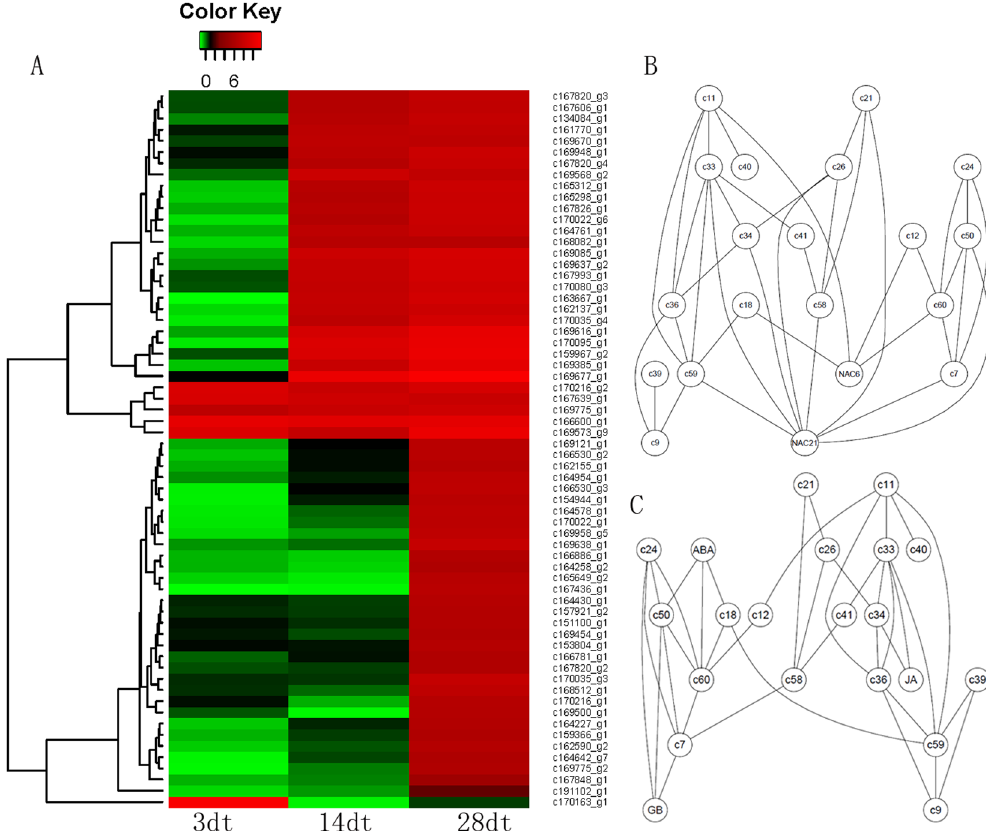
Figure 8. The expression pattern and co-expression network of cytoskeleton-related DEUs. ( A ) The log2 Ratio values of Cm cytoskeleton related DEUs were used for hierarchical cluster analysis with the R heatmap package. Red represents up-regulated unigenes, green represents down-regulated unigenes, and black indicates no significant difference in unigene expression. Details of annotated unigenes shown on the right are provided in Supplementary Table S7. ( B ) The co-expression net containing 18 cytoskeleton-related genes and two NAC transcriptional factors; the gene names, such as c9 and c39 , were corresponding to cytoskeleton related genes and were listed in Supplementary Table S7. ( C ) The co-expression net containing 17 cytoskeleton-related genes and three hormone biosynthesis